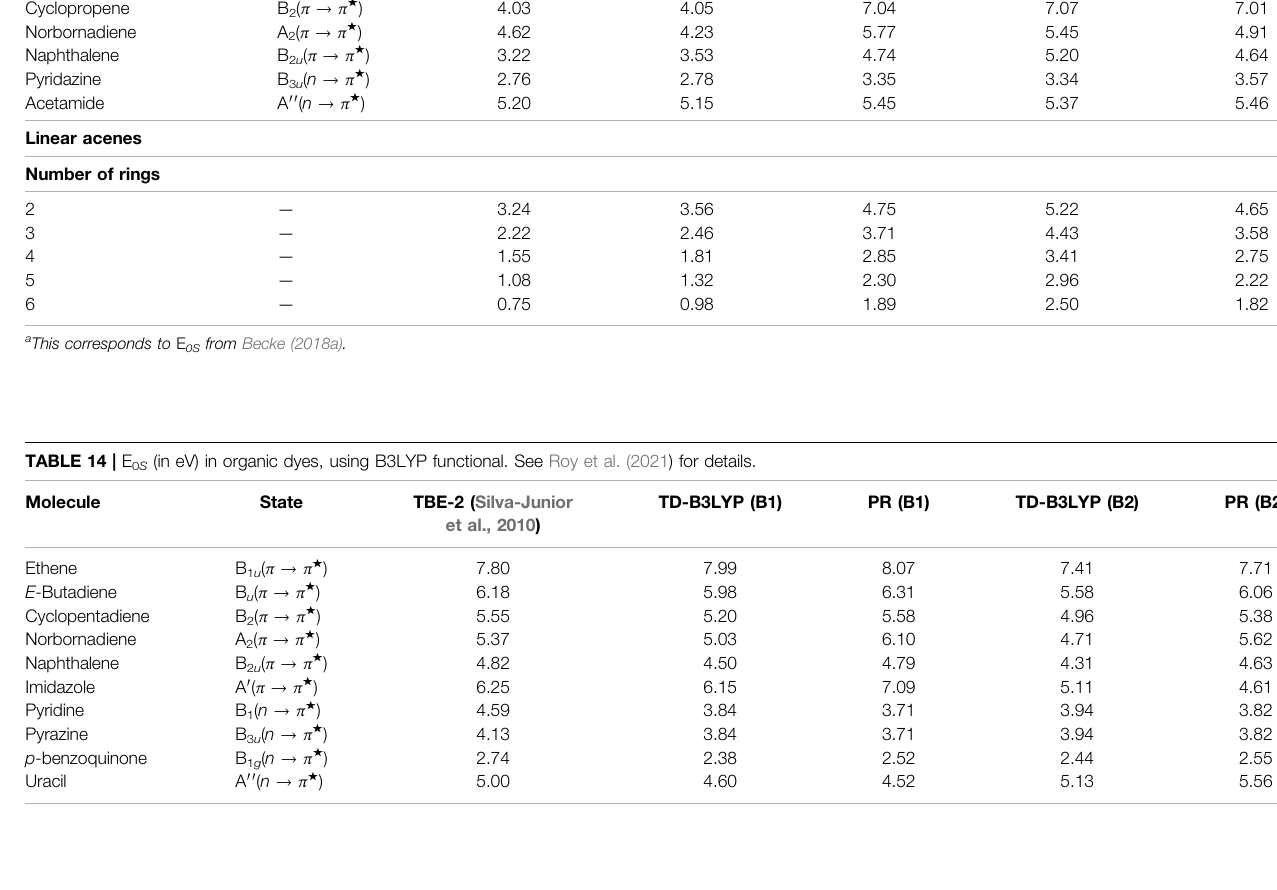
TABLE 13 | Excitation energies of organic chromophores and linear acenes from “ virial theorem. ” These are taken from Ghosal et al. (2021). Orgnaic chromophores